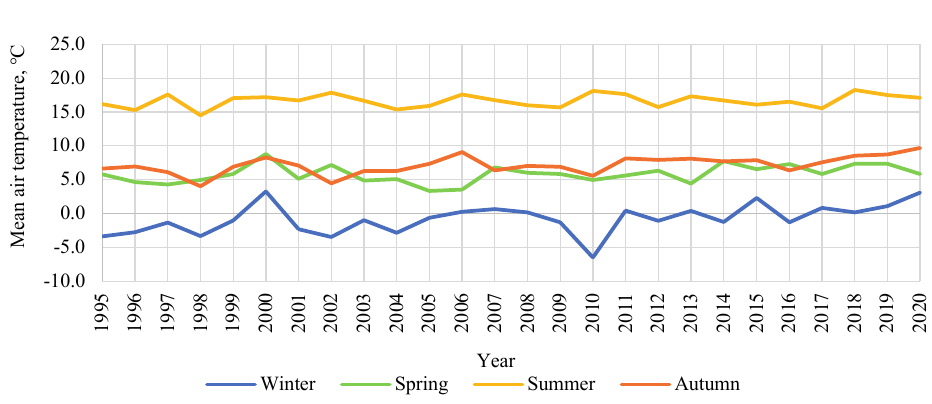
Fig. 4. Mean seasonal air temperature (°C) in the Mellupite monitoring site, time period 1995–2020. In the Mellupite monitoring site during the study period for all seasons positive trend